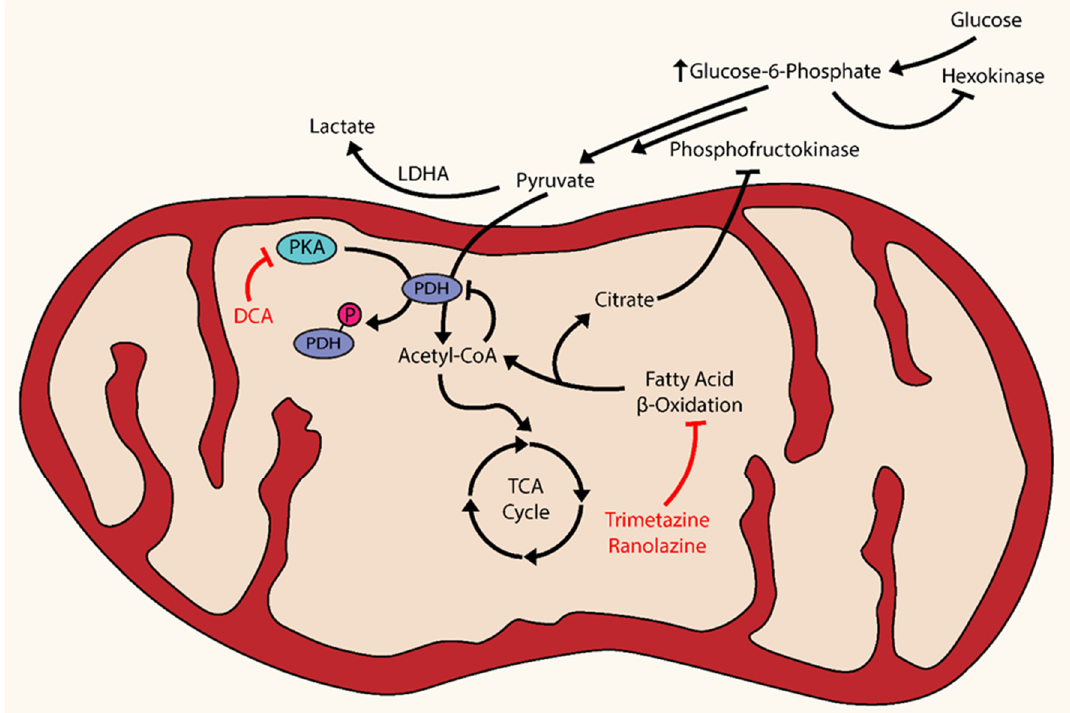
Figure 2. The Randle Cycle in Right Ventricular Dysfunction. The Randle cycle depicts a reciprocal, mutually ‐ inhibitory relationship between glucose oxidation and fatty acid oxidation (FAO). The accumulation of acetyl ‐ CoA and citrate from fatty acid β‐ oxidation inhibits pyruvate dehydrogenase (PDH) and phosphofructokinase, respectively. Moreover, the accumulation of glucose ‐ 6 ‐ phosphate inhibits hexokinase, further attenuating glycolysis. Inhibition of PDH, phosphofructokinase and hexokinase results in the inhibition of glucose oxidation; thus, FAO inhibits glucose oxidation in cardiomyocytes. Intervention with dichloroacetate (DCA) inhibits pyruvate dehydrogenase kinase (PDK) ‐ mediated inhibition of PDH. The FAO inhibitors trimetazidine and ranolazine prevent acetyl ‐ CoA and citrate accumulation, thereby preventing FAO ‐ mediated shutdown of glucose oxidation.